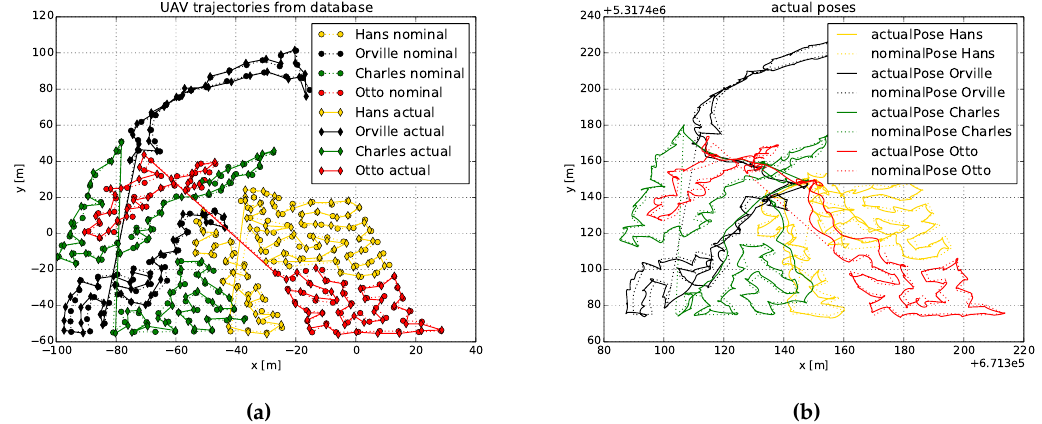
Figure 8. Nominal and actual trajectories of a system composed by 3 drones and 3 regions. ( a ) Trajectories as stored in the DB. ( b ) Trajectories recorded by each drone’s GPS receiver. In ( a ) we plot trajectories in a local coordinate frame, while in ( b ) we plot them in a global coordinate